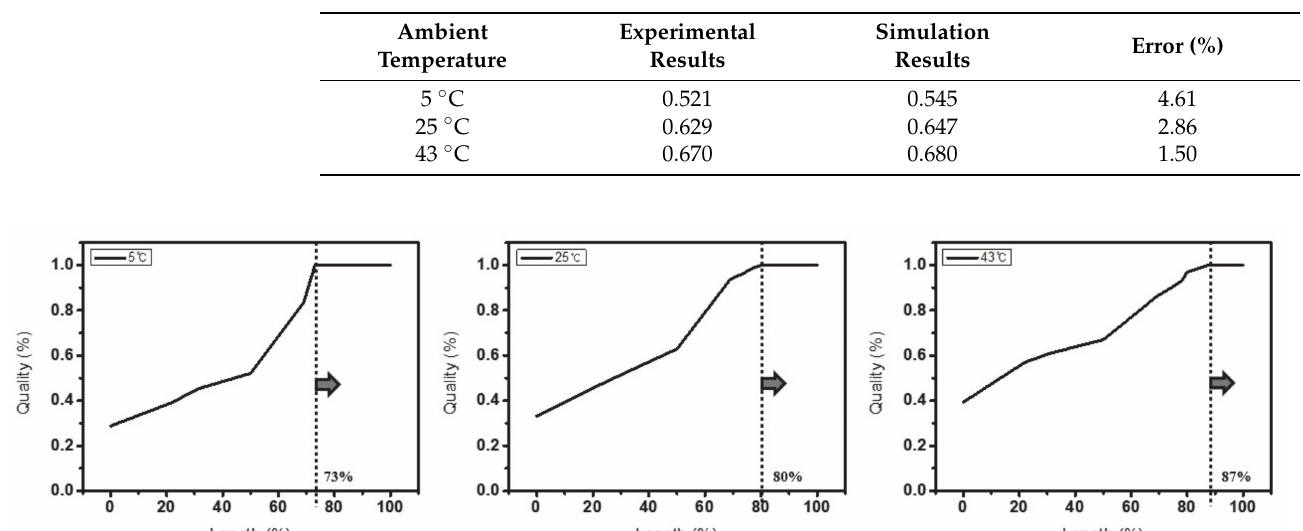
Figure 10. Point where super-heated state occurred with variable ambient temperature and two OTR conditions. In the two-phase region, the refrigerant changes phase as a result of heat transfer